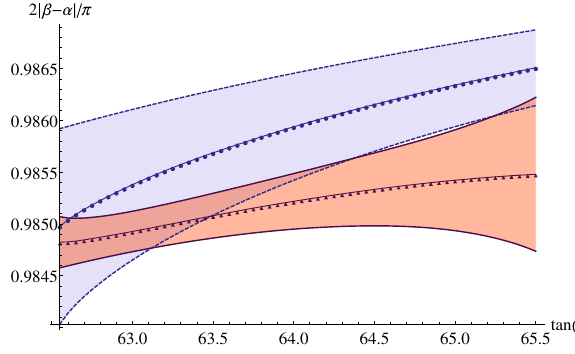
Fig. 4 Mixing angle difference | β − α | with difference between one- loop and two-loop fixed point results as uncertainty. The vacuum-stable and -unstable branches are marked as labelled in Fig.